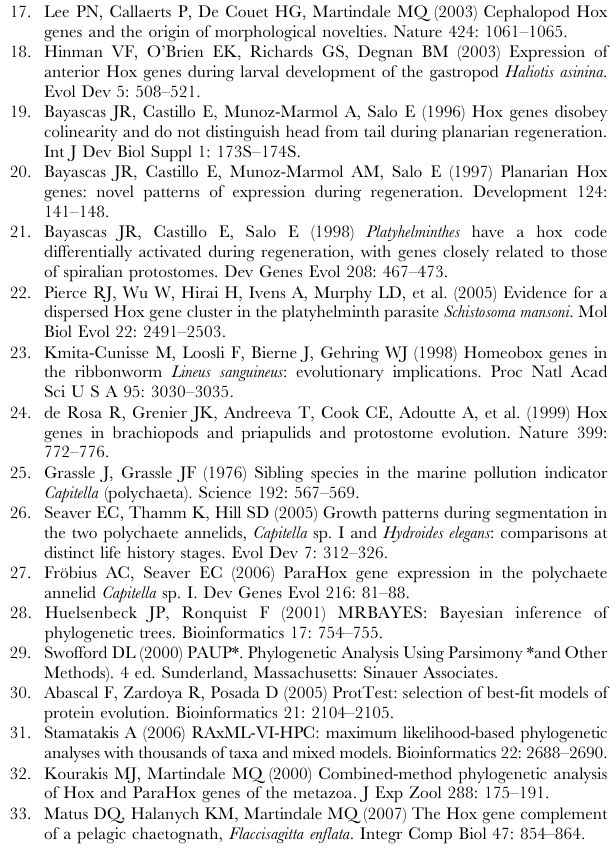
Figure S1 Nexus alignment used in phylogenetic analyses. A 72- amino acid alignment was constructed using the 60 amino acids of the homeodomain and the 12 amino acids immediately 3 9 of the homeodomain from representative bilaterian taxa representing all of the Hox and Parahox PGs. Cc indicates Capitella sp. I; Nv, Nereis virens ; Es, Euprymna scolopes ; Tc, Tribolium castaneum ; Bf, Branchiostoma floridae ; Nw, Nematoderma westbladi ; Sr, Symsagitiffera roscofensis ; Fen, Flaccisagitta enflata ; Sc, Spadella cephaloptera ; Ls, Lineus sanguineus ; Dj, Dugesia japonica ; and Lin, Lingula anatina .